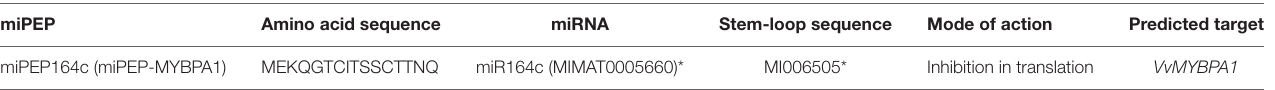
TABLE 1 | Detailed information about the micropeptide identified by an in silico analysis and selected for this study and its corresponding mature miRNA and mode of action. miPEP Amino acid sequence miRNA Stem-loop sequence Mode of